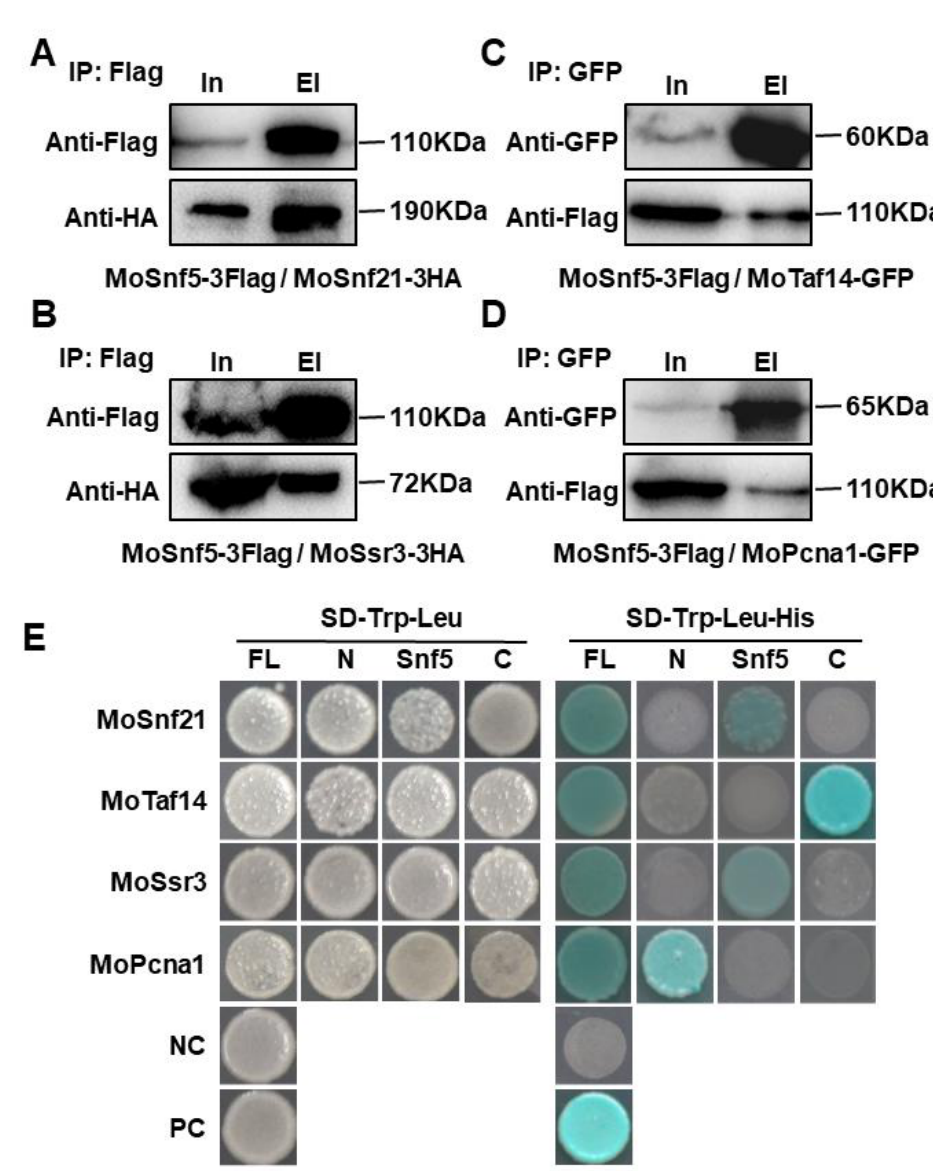
Figure 6. MoSnf5 physically interacts with four proteins via different regions. ( A , B ) Co-immunoprecipitation assay on strains expressing MoSnf5-3 × Flag and MoSnf21-3 × HA ( A ) or MoSsr3-3 × HA ( B ). Proteins eluted from anti-FLAG M2 beads were used for Western blot analysis with anti-FLAG or anti-HA antibodies. ( C , D ) Co-immunoprecipitation assay on strains expressing MoSnf5-3 × FLAG and MoTaf14-GFP ( C ) or MoPcna18-GFP ( D ). Proteins eluted from anti-GFP beads were used for Western blot analysis with an anti-GFP or anti-FLAG antibodies. In, input; EI, elution. ( E ) Physical interaction between MoSnf5 or its different regions and four proteins by yeast two-hybrid approach. The pGBKT7-MoSnf5 or its different regions and pGADT7-MoSnf21, MoTaf14, MoSsr3, or MoPcna1 were co-transformed into yeast strain AH109, and selected on SD-Trp-Leu and SD-Trp-Leu-His plus X-gal. NC, negative control; PC, positive control.